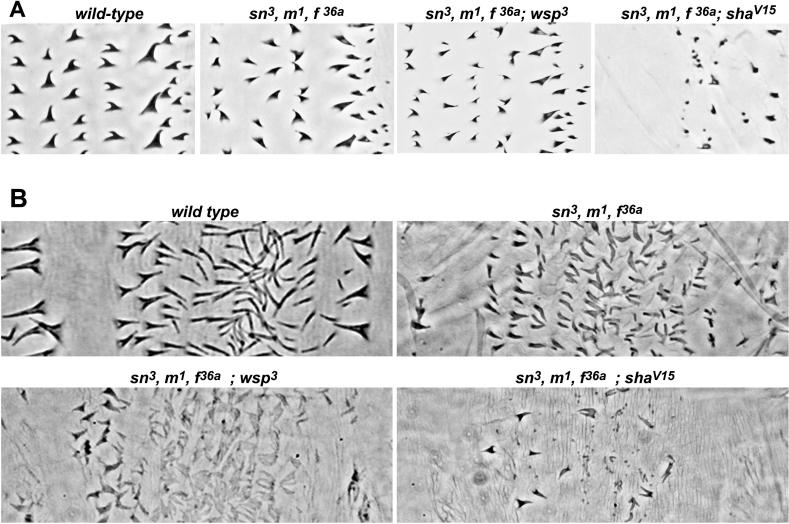

svb Downstream Targets Act Collectively in the Formation of Both Denticle and Dorsal Hairs(A) Denticle defects resulting from the combinations of individual mutations of sn3, f36a, m1, sha1, and wsp3 (views of the ventral region of the A4 segment). Embryos triple mutant for m, sn, and f display an aggravated phenotype with respect to each simple mutant or double mutant. This leads to poorly differentiated denticles, which display an extremely thin tip and a small triangular base. In addition, the lateral spacing of mutant denticles is reduced, a consequence of denticle splitting with two tiny extensions side by side. The combined inactivation of sn, f, m, and wsp further increases the severity of mutant phenotypes, producing very small and highly abnormal denticles. Similarly, in embryos simultaneously lacking sn, f, m, and sha, the few remaining extensions are atrophic, and numerous denticles are replaced by naked cuticle.(B) svb downstream targets are required for dorsal hair formation. The dorsal region of a wild-type abdominal segment displays a stereotyped arrangement of epidermal extensions presenting a specific morphology: a row of large trichomes pointing anteriorly, a stripe of naked cuticle, three rows of extensions of intermediate size, and several rows of thin hairs. The cumulated inactivation of svb targets profoundly impairs dorsal hair formation. Hairs that display the superimposition of single mutant phenotypes are thickened (m), crooked (sn, f) and split (f, wsp, sha). In sn3, f36a, m1 triple mutants, dorsal hairs are severely reduced in size and, in several cases, the formation of dorsal hair is abrogated, leaving abnormal naked regions, as best seen in the first row of trichomes. These phenotypes are even more pronounced following the combination with wsp mutation, and culminate in embryos lacking m, sn, f, and sha, where most dorsal hairs are absent and replaced by naked cuticle. In some cases, atrophic dorsal hairs are seen as duplicated spots, revealing hair splitting as observed in sha and f embryos. All pictures correspond to the A4 segment.